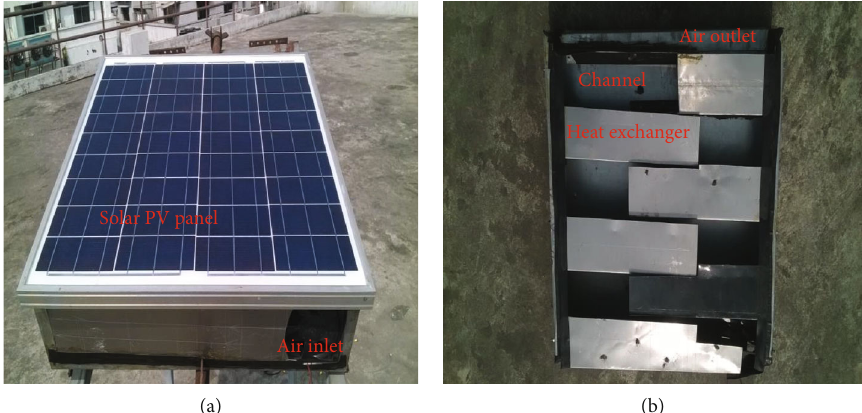
Figure 3: (a) The solar PV panel installed on the top of the heat exchanger. (b) Internal construction of the heat exchanger.